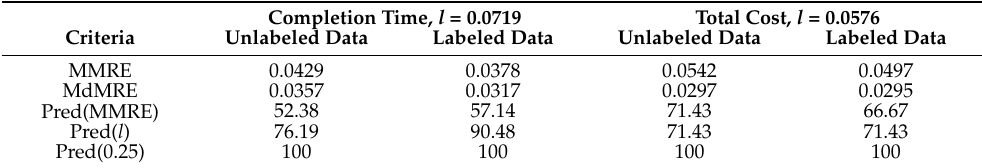
Table 11. Comparison of AdaBoost evaluation